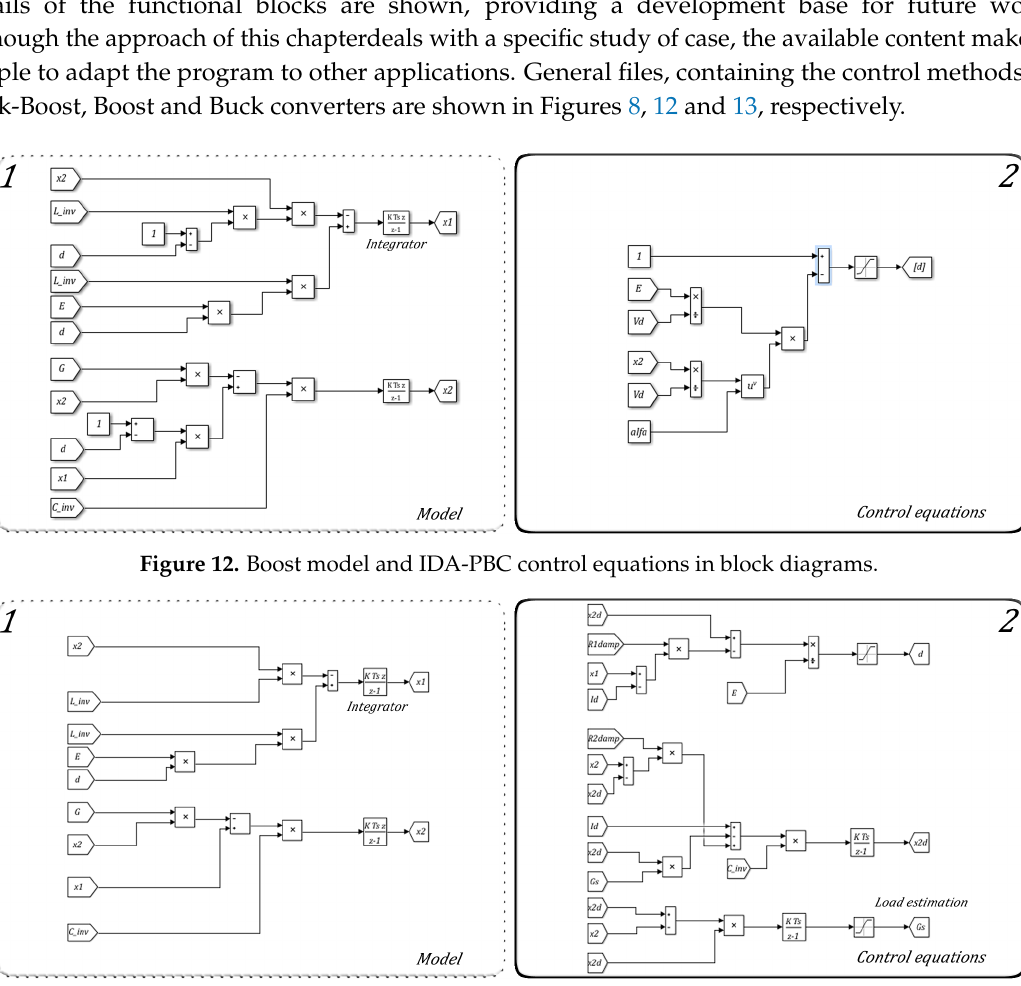
Figure 13. Buck model and PBC control equations in block